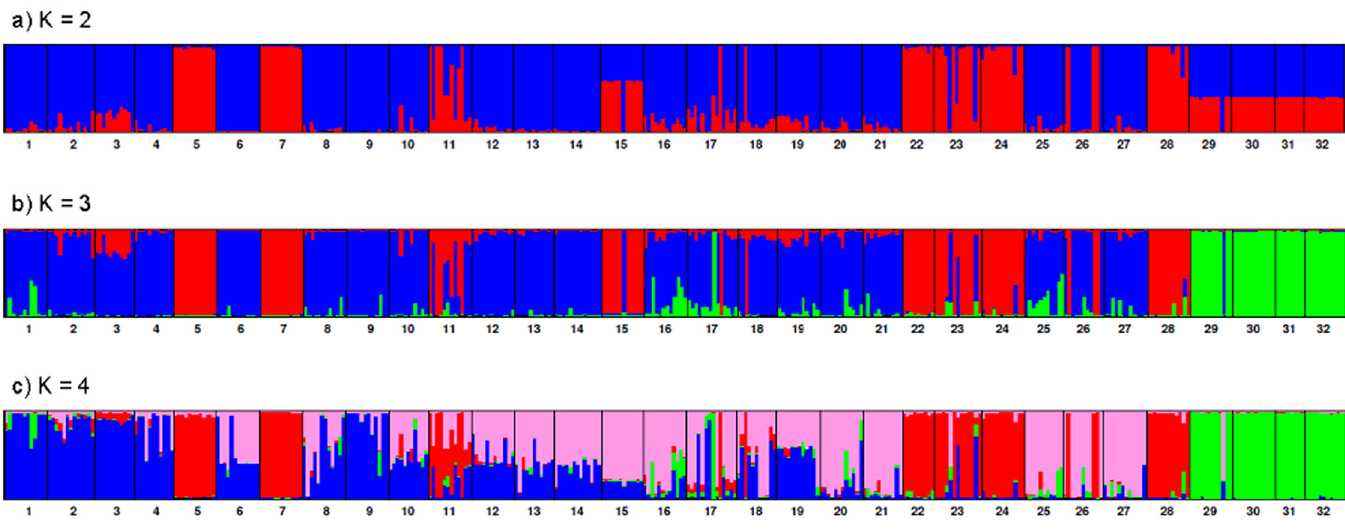
Fig 2. Assignment of individuals to genetic clusters identified by InStruct, for K = 2 to K = 4. Populations are sorted from left to right by decreasing latitude. Clusters are depicted in the following colours: cluster 1 = blue; cluster 2 = red; cluster 3 = green; cluster 4 =